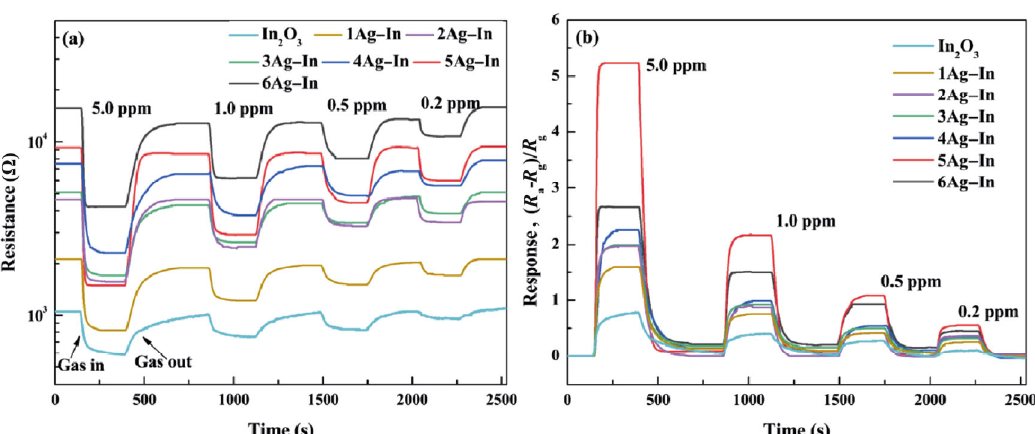
Fig. 9 (a) Real-time resistance change and (b) dynamic response curves of the seven sensors towards 0.2, 0.5, 1, and 5 ppm isopropanol at 300 . ℃